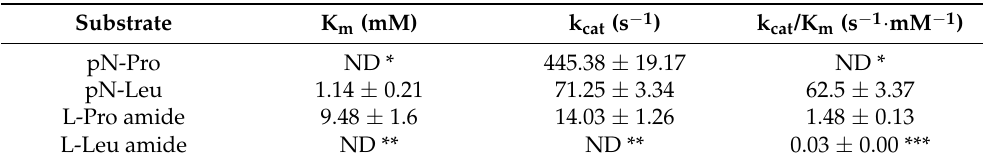
Table 2. Kinetic parameters of PsyPAH with L-Pro and L-Leu amide and p -nitroanilide derivatives (pH 7.0, 35 ◦ C). * Could not be determined due to detection limit of the determination method. ** Could not be determined due to the solubility of this substrate. *** Obtained from the linear part of the kinetic plot (see Figure